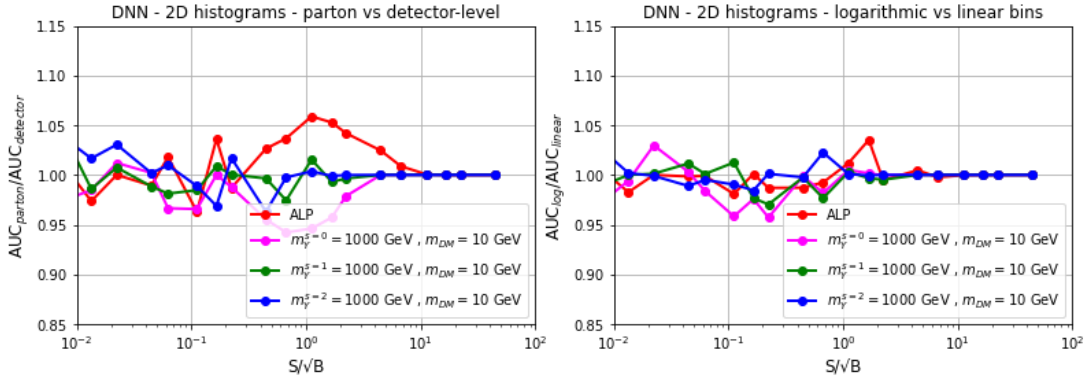
Figure 26: Left panel: DNN performance of parton versus detector-level data. Right panel: DNN performance of linear versus logarithmic representations of p j panels, the benchmark models dubbed on-shell are